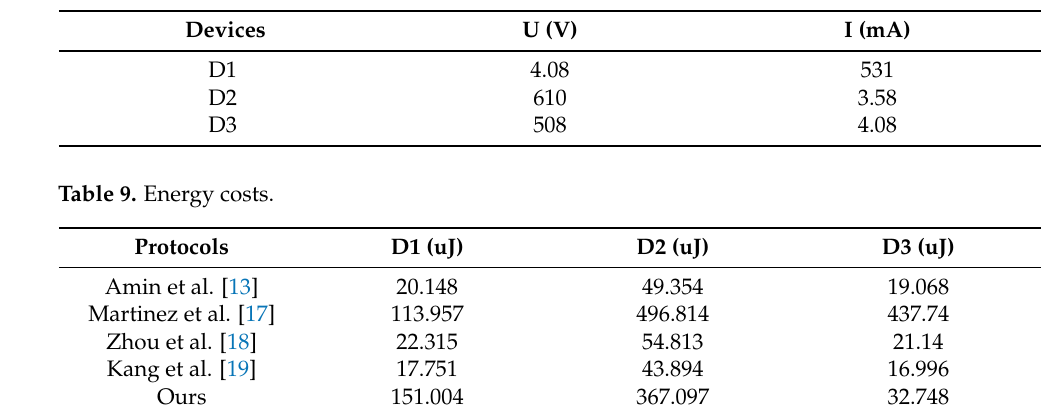
Table 8. Voltage and current of devices.